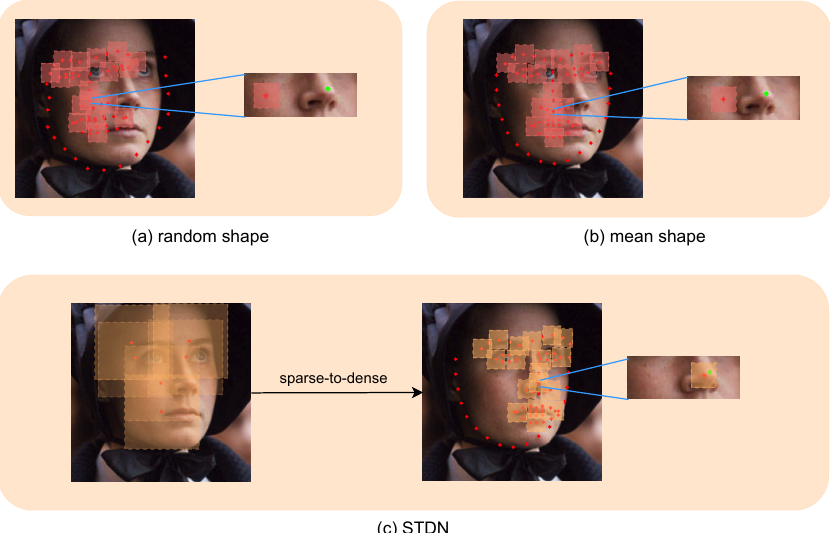
Figure 1. Shape-indexed local patches of three sampling approaches where red points represent the initial landmarks and green points represent the ground-truth landmarks. ( a , b ) show the sampling result using the random shape and mean shape, respectively, as initial landmarks on a face with large pose variation. ( c ) shows our sampling approach, in which the local patches capture the ground-truth landmarks more precisely than the other two